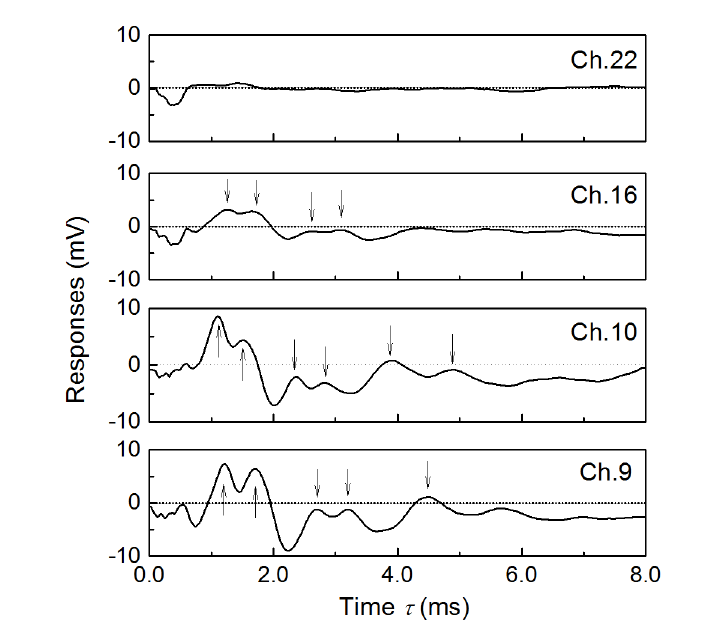
Fig. 7 Comparison of eABR results between Ch. 9, 10, 16, and 22 at peak sound pressure level of 101 dB and base frequency of 10